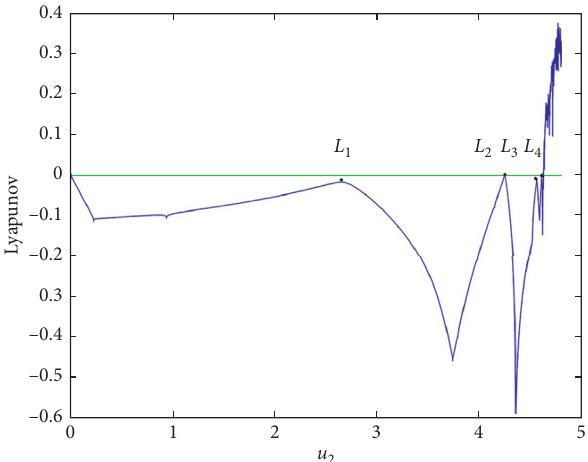
Figure 3: Lyapunov exponent diagram with respect to u